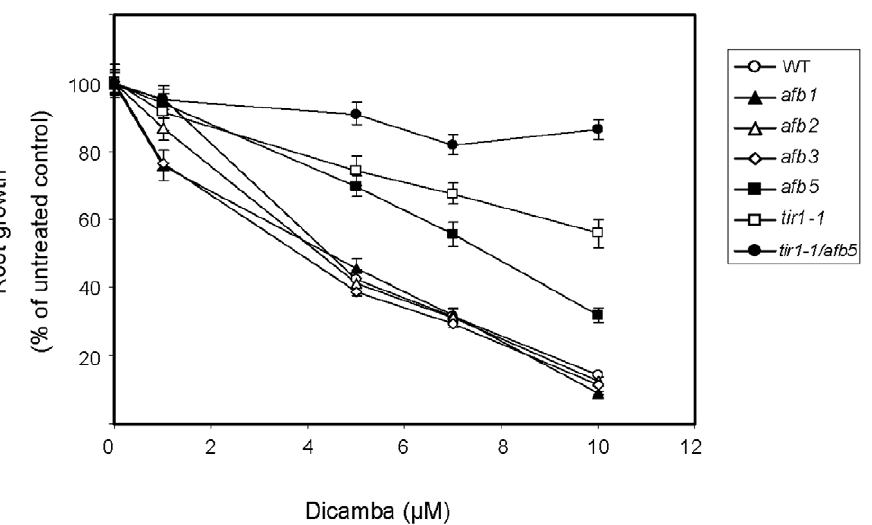
Figure 5. Effects of increasing dicamba concentrations on root lengths of TIR-like, F box receptor mutants. Data represents a comparison of the effects of increasing concentrations of dicamba on the root lengths of WT and TIR/AFB mutants. Roots measured after 8 days on MS-media containing 0, 1, 5, 7 or 10 m M dicamba and converted to a percentage of the average root length of the untreated control plants. Measurements were taken on at least 20 seedlings per treatment. (Error bars = standard error)